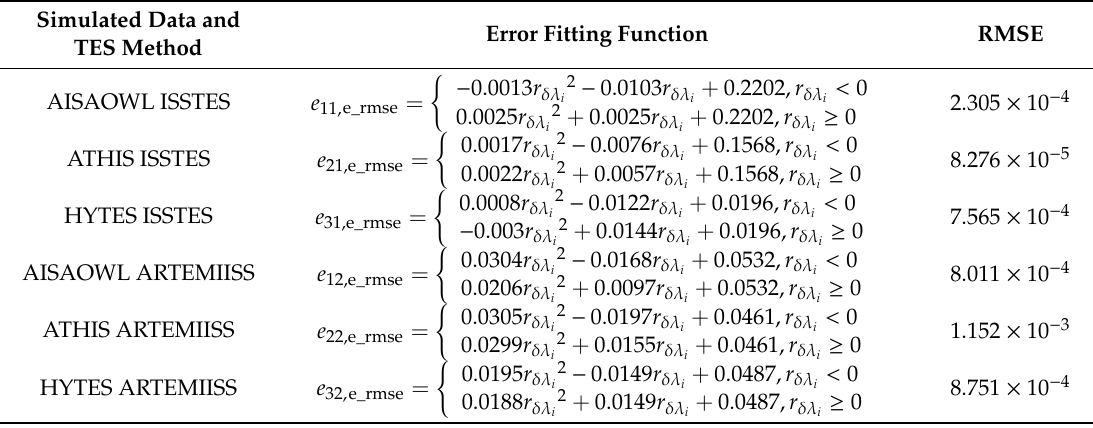
Table 4. The LSE error fitting function about center wavelength shift